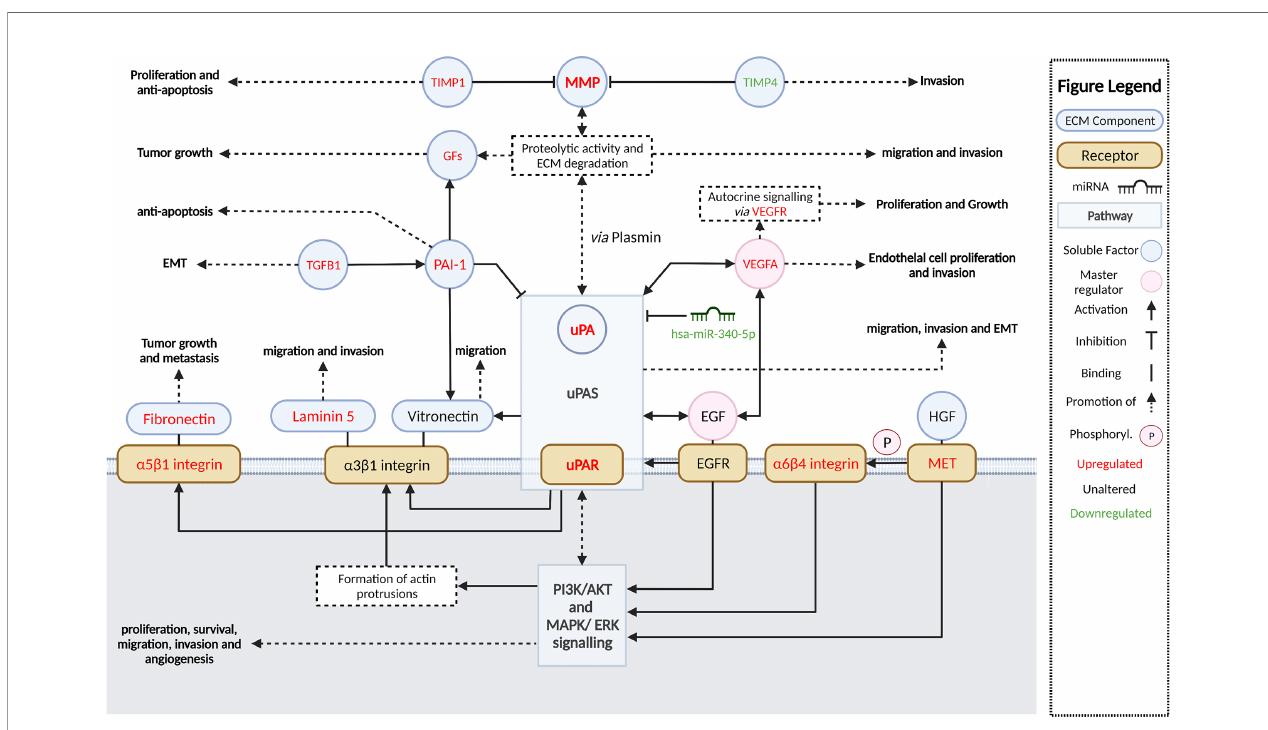
FIGURE 7 | Summary and schematic illustration of key pathways and regulators identi fi ed as up- or downregulated in metastatic versus non-metastatic tumors or SES in this study. The urokinase plasminogen activator system (uPAS) plays a central role in remodeling the extracellular matrix (ECM) promoting metastasis. The uPAS exerts its activity by enhanced uPA-mediated conversion of co-localized plasminogen to plasmin and subsequent activation of matrix metalloproteases (MMP). PAI-1 ( SERPINE1 ) can inhibit uPA activity but is also upregulated and contributes to cell signaling. MMPs and plasmin cleave and remodel the ECM leading to the release of latent growth factors (GFs) such as EGF, VEGF-A, TGF- b , and HGF (hepatocyte growth factor). By binding to their cognate receptors, EGFR and VEGFR (encoded by FLT1 ), and c-MET, these growth factors in turn act as important upregulators of the uPAS ( via uPAR) and other downstream effectors, which induce large-scale cellular changes that further promote ECM remodeling, cellular migration, and invasion and, ultimately, metastasis. A few of these growth factor receptors are themselves overexpressed (i.e., MET , FLT1 ) and can drive invasion and metastasis regardless of growth factor activation. Aberrant miRNA expression, such as downregulated has-miR-340-5p, is also associated with upregulated uPAR expression. Direct and indirect downstream effectors of the uPAS include vitronectin, focal adhesions via integrins and focal adhesion kinase (FAK), the proliferation, and survival pathways MAPK/ERK PI3K/Akt/mTOR and VEGF-A, which facilitate increased protection against apoptosis/anoikis, increased cell proliferation, and EMT and angiogenesis; these are also important for invasion and metastasis. Created with